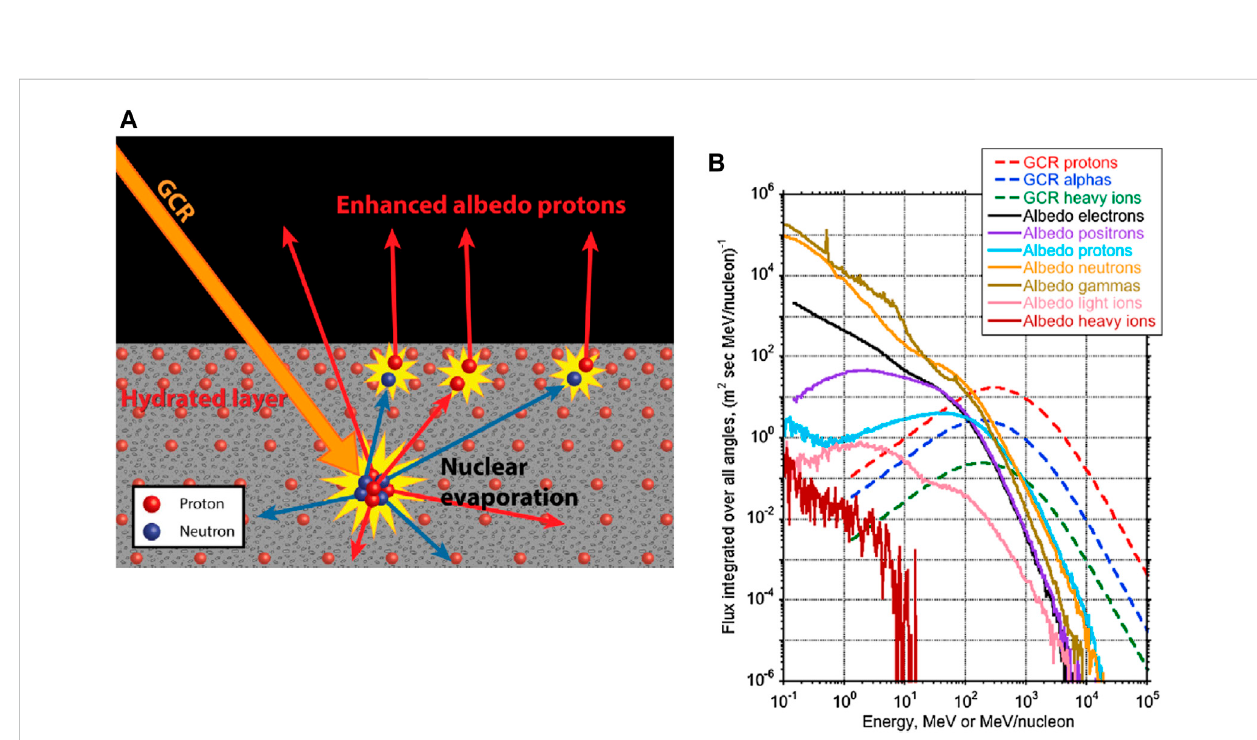
FIGURE 5 (A) : Illustration of the effects of a hydrated layer of lunar regolith in the production of GCR albedo (secondary) protons. The nuclear evaporation process from deep in the regolith produces abundant secondary particles in all directions. (From: Schwadron et al., 2016). (B) : Energy spectra of pristine GCR species (dashed lines) and of lunar albedo species (continuous lines), calculated with the Geant4 simulation toolkit. (From: Looper et al.,